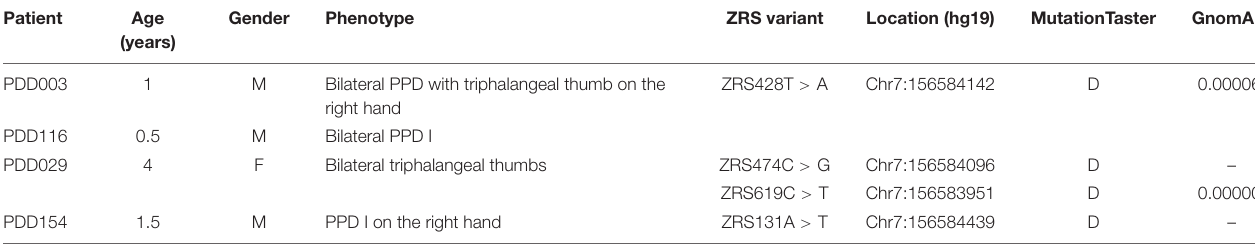
TABLE 4 | Phenotypes and genotypes of patients with PPD with ZRS variants.